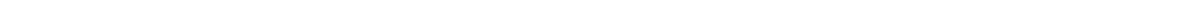
Fig. 3 MYC facilitates ductal-neuroendocrine lineage plasticity in PDA. a KPC or KPC Myc fl /+ pancreatic tissues from mice with end stage disease were stained for SYP and Pan-CK by IF. Scale bars indicate 100 μ M. Examples of co-stained cells are marked with white arrows. b The percentage of CK-SYP dual positive cells within ductal structures relative to the total number of PanCK positive cells was quanti fi ed. n = 4 mice per group. Error bars indicate standard error of mean. * P = 0.029 one-tailed Mann Whitney test. c Interrogation of MYC ChIP-seq data from KPC tumor cells. GSEA analysis shows enrichment in MYC DNA binding peaks within 1000bp of genes that are upregulated in NEPC vs. PCA 11 . d Schematic depicting generation of the LSL- Kras G12D ;LSL-ROSA- Myc ;Pdx1- Cre (KMC) mice. e Expression of deregulated MYC in combination with oncogenic KRAS in KMC mice reduces overall survival compared to KC mice. The number of mice and median survival of each arm is shown in the legend. f KMC pancreatic tissues were stained for PanCK and SYP by IF. Examples of CK-SYP co-stained cells are indicated with white arrows. Scale bars indicate 100 μ M. g Kras G12D ;Pdx1-Cre (KC) and KMC pancreatic tissues were stained for SYP by IHC. The percentage of SYP positive cells within the ductal epithelium relative to the total number of ductal cells was quanti fi ed in 5 – 10 of each lesion grade per genotype. Error bars indicate standard error of mean. *** P < 0.001, two-way